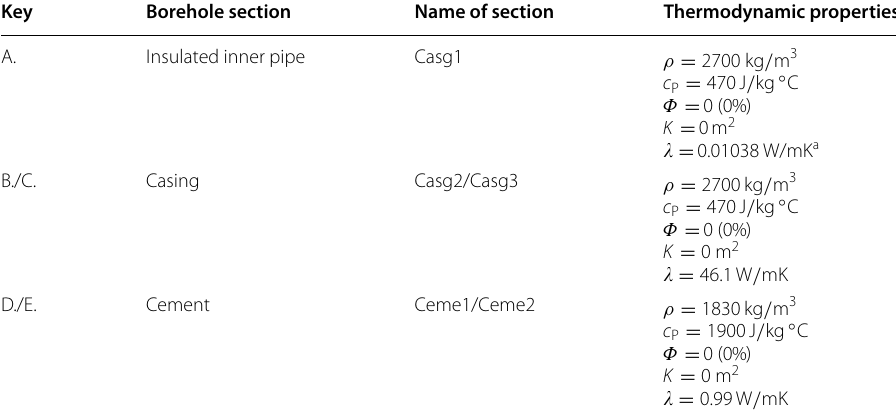
Table 5 Key borehole properties in support of Fig. 2